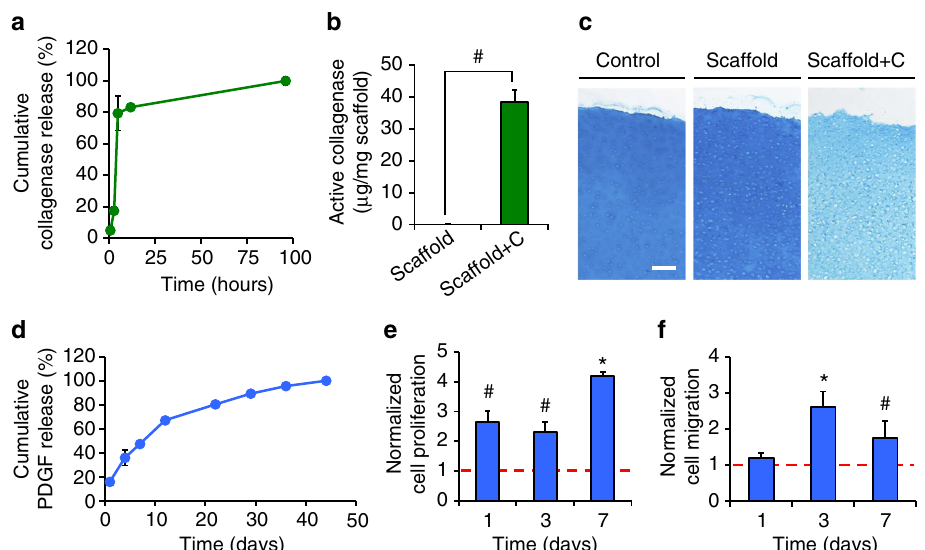
Fig. 4 Controlled and active biomolecule release from tri-component nano fi brous scaffolds. a Cumulative collagenase release (% of total) from scaffolds containing collagenase (Scaffold + C) over 96 h ( n = 5 samples, mean ± s.d.). Collagenase activity is present in Scaffold + C but not control Scaffold groups ( n = 5 samples/group, mean ± s.d.), as measured with b cleavable peptide substrates or c decreased Alcian Blue staining of cartilage explants after 72 h of incubation with scaffolds. Scale = 100 µ m. d Cumulative platelet-derived growth factor-AB (PDGF-AB) release from scaffolds containing PDGF-AB (Scaffold + P) over 6 weeks ( n = 5 samples, mean ± s.d.). e Proliferation and f migration of adult meniscal cells exposed to releasate from Scaffold + P groups at 1, 3, or 7 days of release ( n = 5 samples/group, mean ± s.d.) normalized to the control Scaffold group (red dashed line). # = p < 0.05 vs. Scaffold, * = p < 0.05 vs. all other